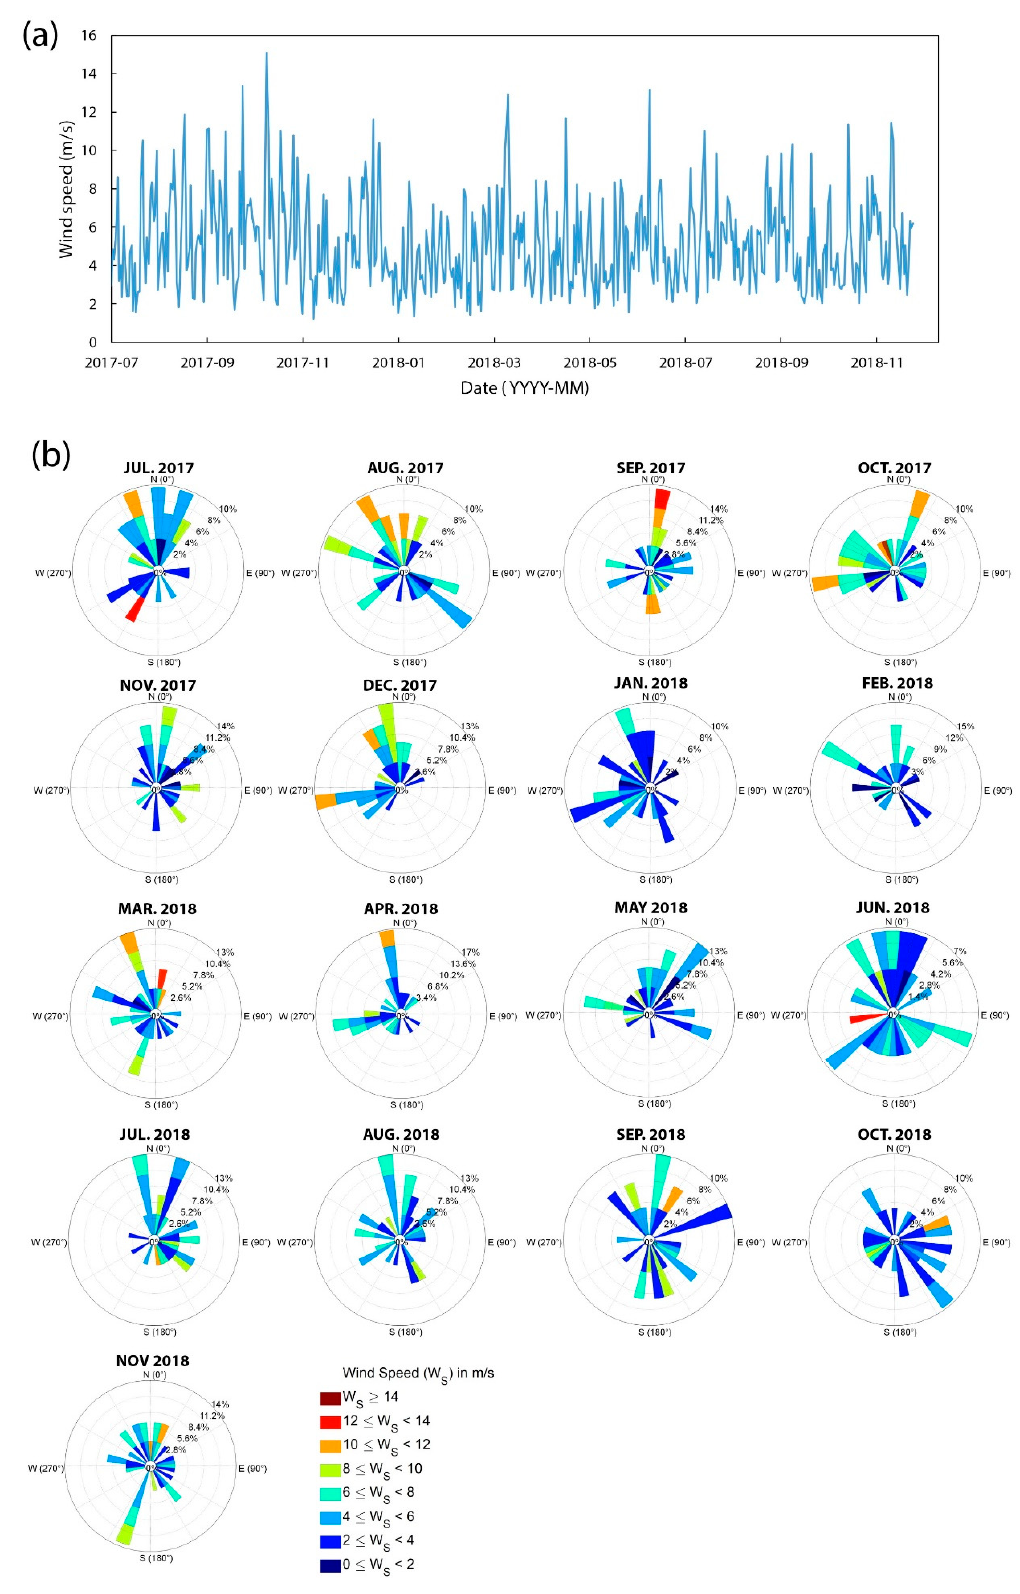
Figure 5. ( a ) Changes in the wind speed around iceberg A68A predicted by the MERRA-2; ( b ) Wind rose showing wind speed and direction for each month during July 2017–November 2018.